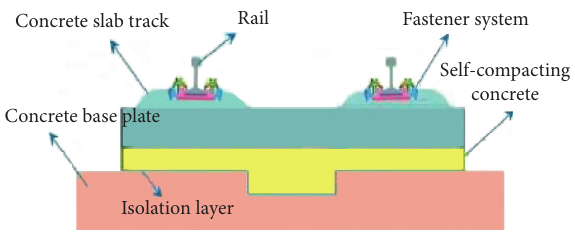
Figure 1: The structures of a traditional ballastless